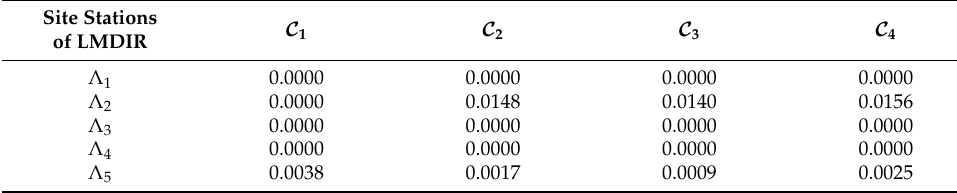
Table 6. Positive distance matrix.